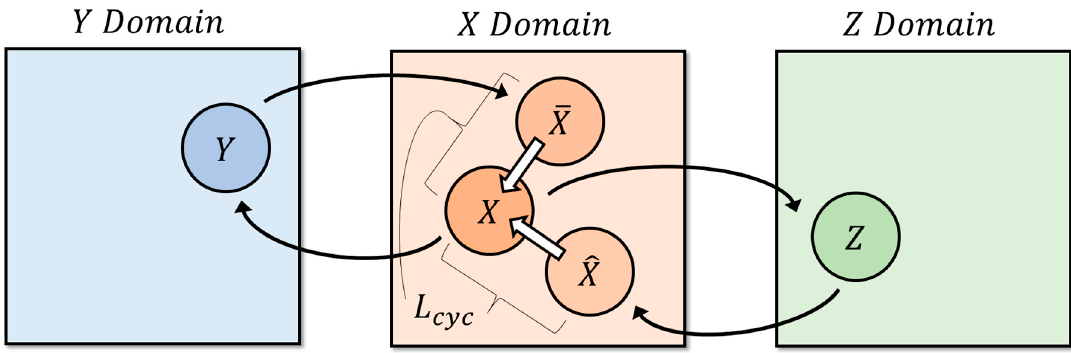
Figure 6. Cycle consistency loss L (cid:3030)(cid:3052)(cid:3030) for the cycle GAN model.